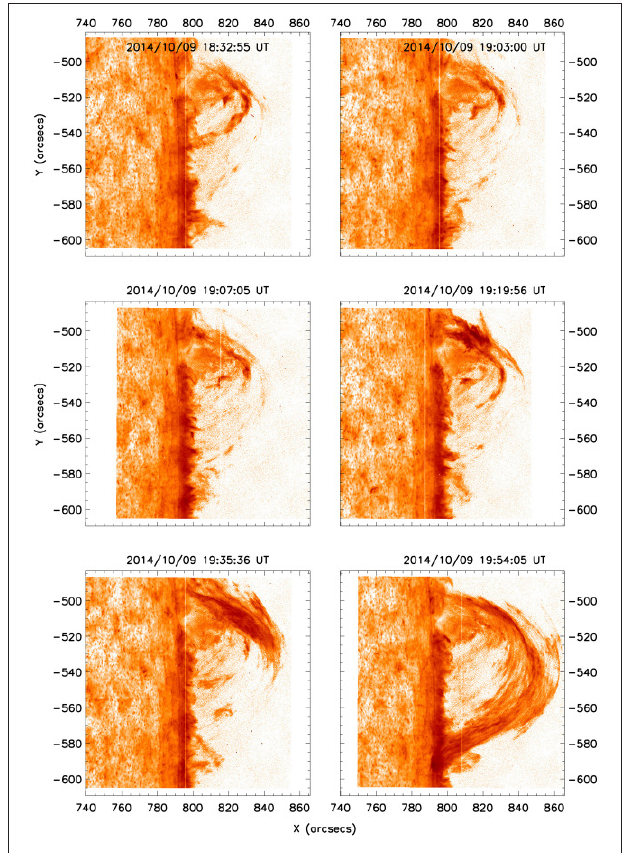
FIGURE 5 | IRIS Si IV 1400 Å